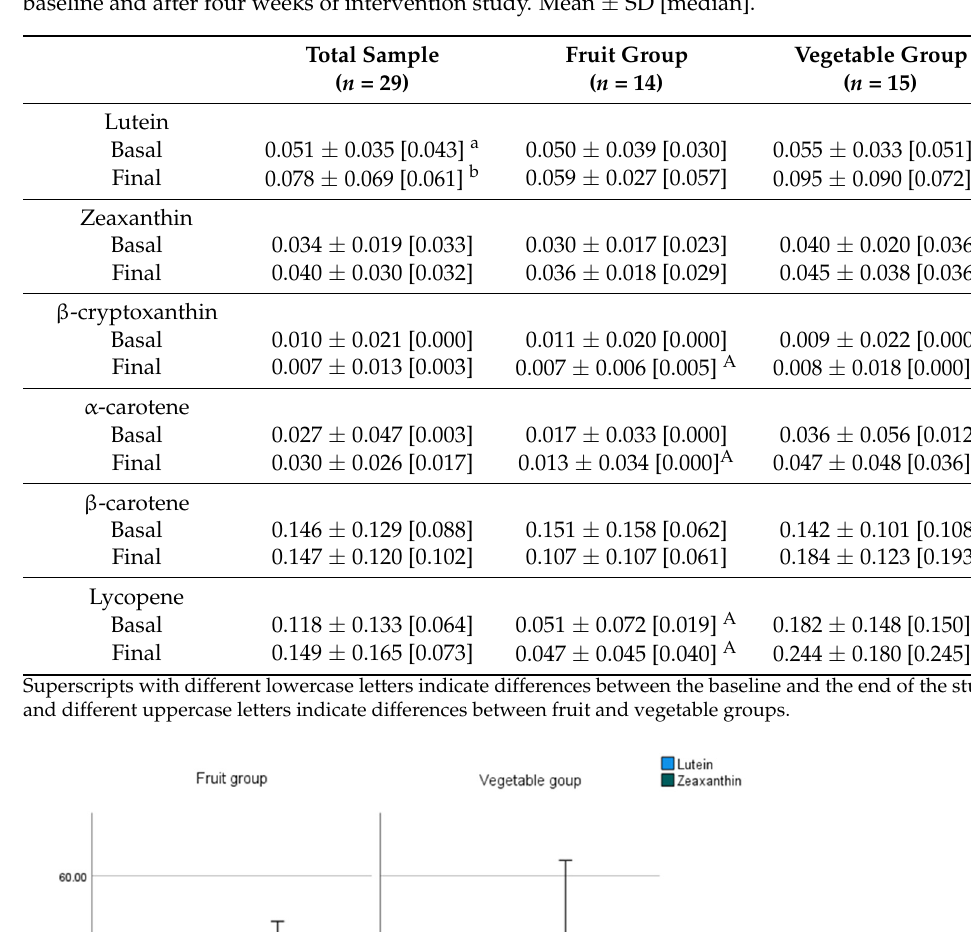
Table 5. Lutein and other major carotenoid concentrations in faeces ( µ mol/day, dry weight) at baseline and after four weeks of intervention study. Mean ± SD [median].